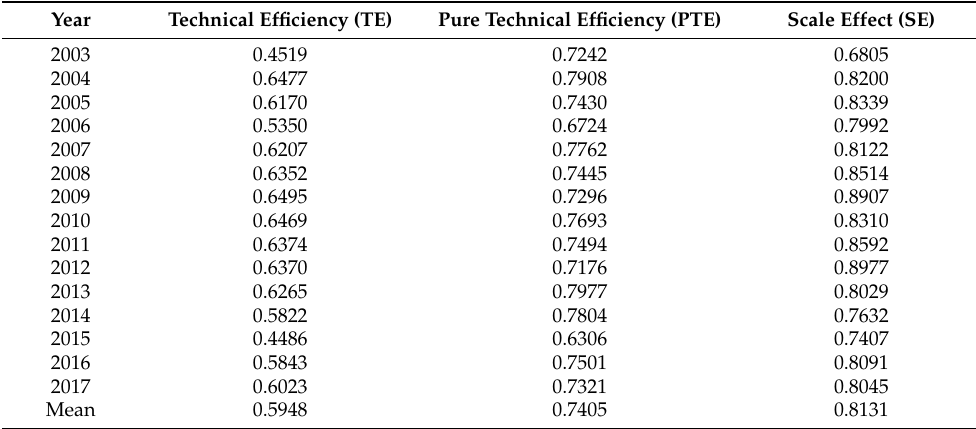
Table A1. National efficiency analysis results from 2003 to